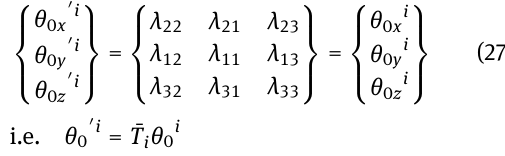
ξi and The relationship between the nodal rotations θ 0 θ 0 i for the i th node can be obtained as follows, For a cylindrical shell the angle between the global x axis and tangent ξ can be obtained easily as this tangent 1 is actually tangent to the circle x 2 + z 2 = R 2 in x − z plane. Differentiating this expression for the circle yields, tan α = − x . α is the angle between the axes global x axis and ξ and 1 z setting the angle between global y axis and tangent ξ zero, 2 as the radius in that direction is zero. For spherical shell the angle between global y axis and tangent ξ is the tangent 2 to the circle y 2 + z 2 = R 2 in y − z plane. For conical shell the angle between global y axis and ξ becomes half the 2 vertex angle 𝛾 of the cone. Considering the angle between v the global y axis and ξ is β i.e. tan β = − y . Using this, the 2 z ξi and θ i for the i th node can be relationship between θ 0 0 obtained. Transformation matrix T ξ for transforming i